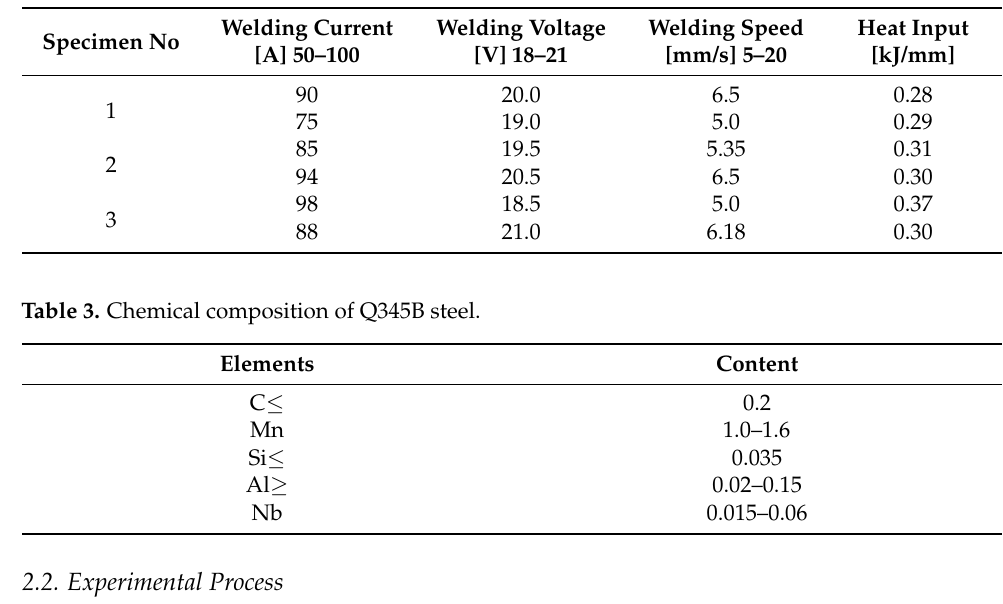
Table 2. Welding parameters.